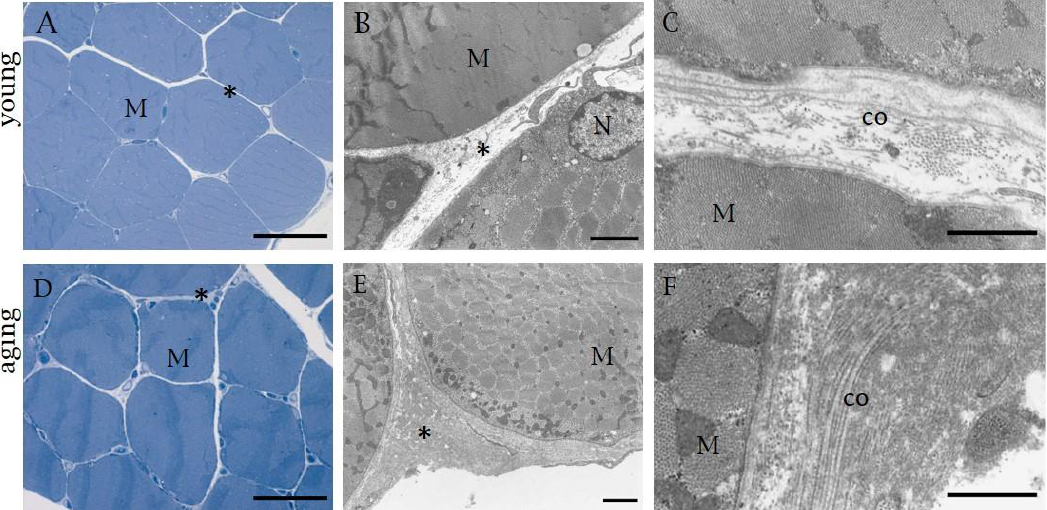
Figure 2. Semithin sections stained with 1% Toluidine blue ( A , D ) and TEM images ( B , C , E , F ) of hu-